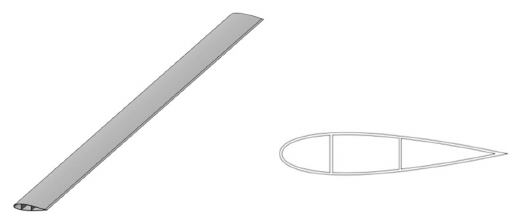
Figure 1: Model of LD-VAWT.